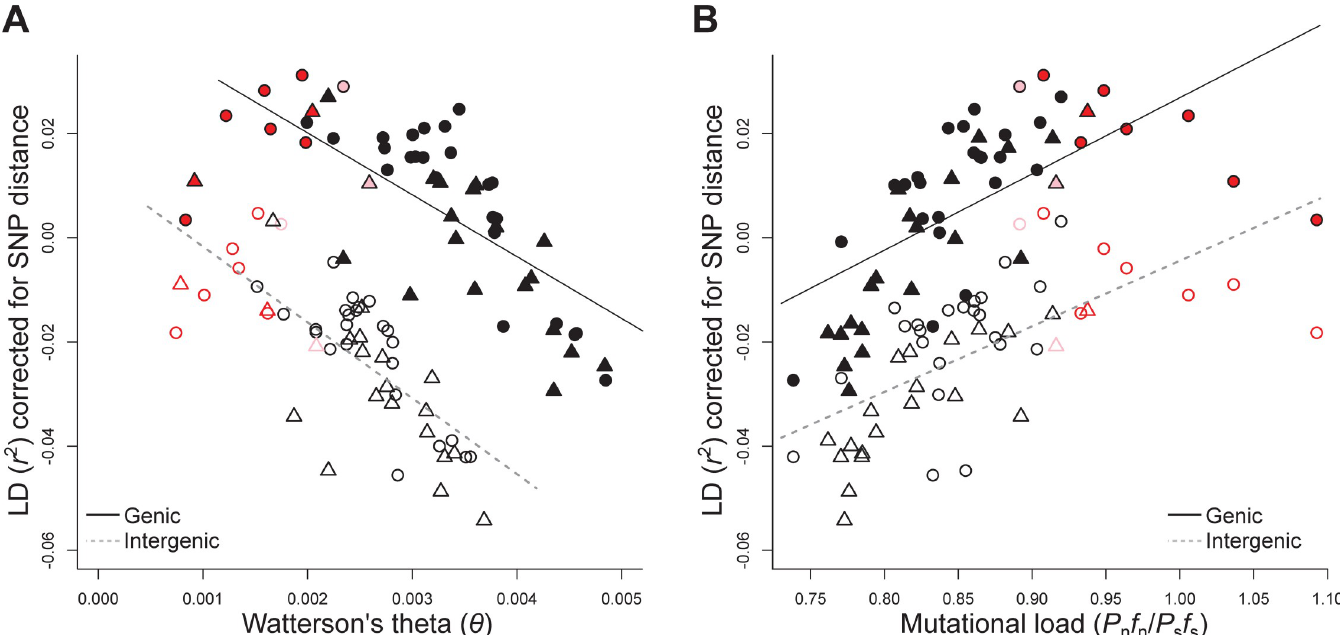
Fig 3. Relationship between Watterson’s theta ( θ ) (A), mutational load (B) and average genome-wide linkage disequilibrium (LD, distance-corrected r 2 between pairs of SNPs). Mutational load was estimated as the product of non-synonymous polymorphic sites ( P n ) and their mean derived allele frequency ( f n ) divided by the analogous product but for synonymous polymorphic sites ( P s f s ). Each symbol represents the average estimate of a population. Open and filled symbols are the genomic estimates for intergenic and genic regions, respectively. Circles represent populations from the west, triangles those from the east. Symbol colour indicates the mating system: outcrossing (black), mixed-mating (pink), and selfing (red). The model-predicted regression lines are shown for intergenic (dashed line) and genic (solid line) regions.